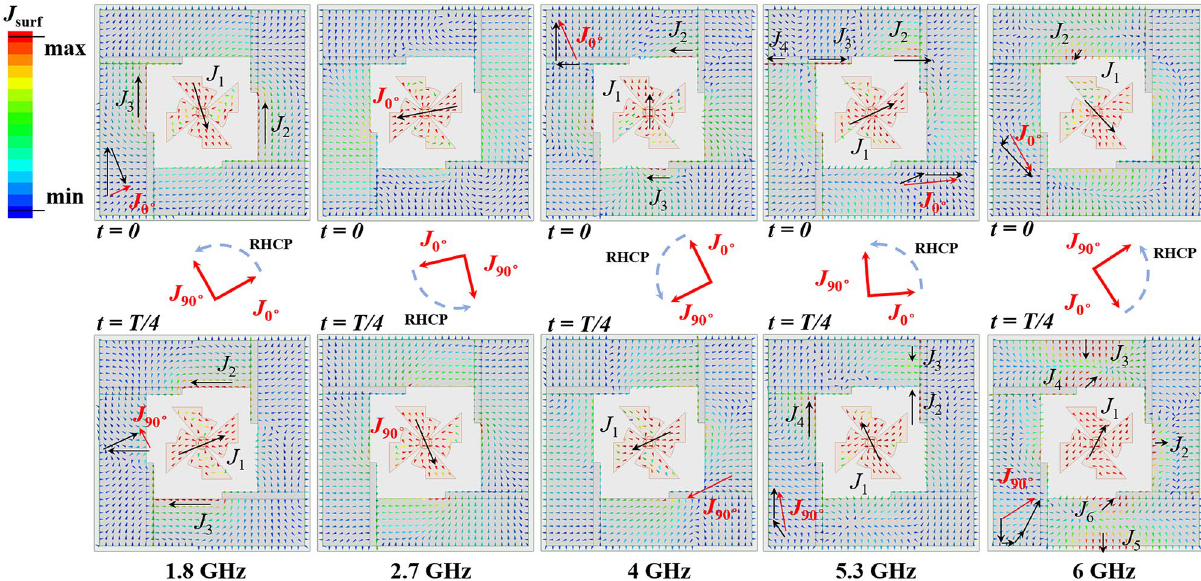
Figure 4. Simulated surface current distribution of the proposed CP antenna.